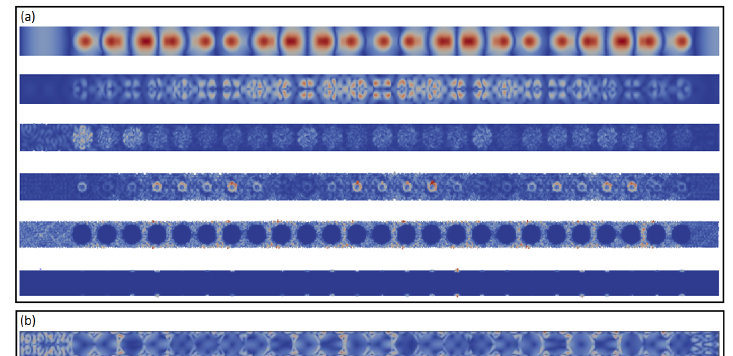
Figure 6. ( a ) Visualization of the normal modes obtained in the system with E i = 0.2 and r = 25 Å. E m The frequencies of the characteristic normal modes (from top to bottom) are: ν = 0.325195 THz ( ω = 2 πν = 2.04 THz); ν = 0.790191 THz ( ω = 4.96 THz); ν = 2.00000 THz ( ω = 12.57 THz); ν = 3.99998 THz ( ω = 25.13 THz); ν = 6.00019 THz ( ω = 37.70 THz); ν = 14.22239 THz ( ω = 89.36 THz). ( b ) Visualization of one normal mode obtained in the system with E i = 10 and r = 25 Å. The frequency of the mode is: E m ν = 2.00281 ( ω = 12.58